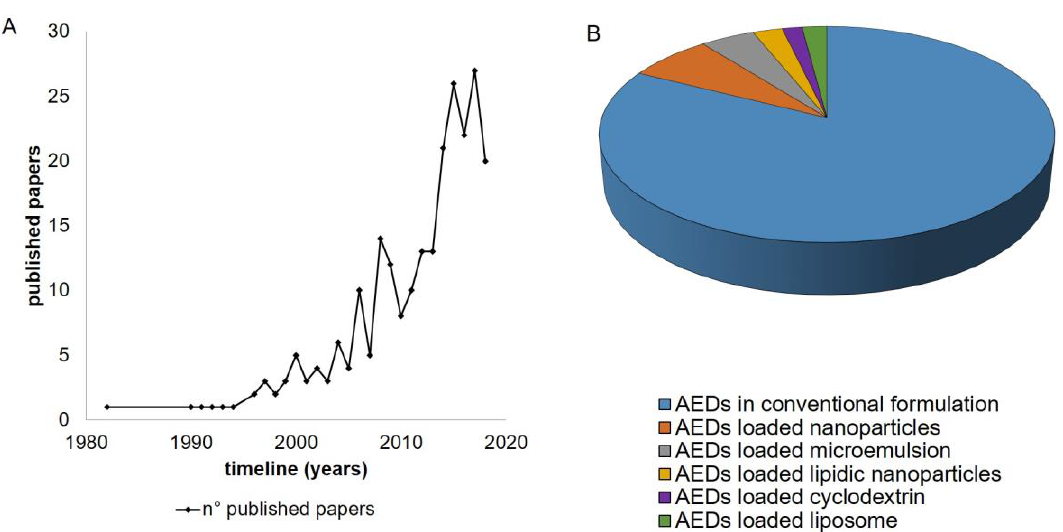
Figure 2. Publication trends in the field of antiepileptics and epilepsy ( A ), and the percentage of each type of nanomedicine with refined terms: nanoparticles, microemulsion, cyclodextrins, liposome, and solid lipid nanoparticles (SciFinder) ( B ). AEDs –antiepileptics’ drugs